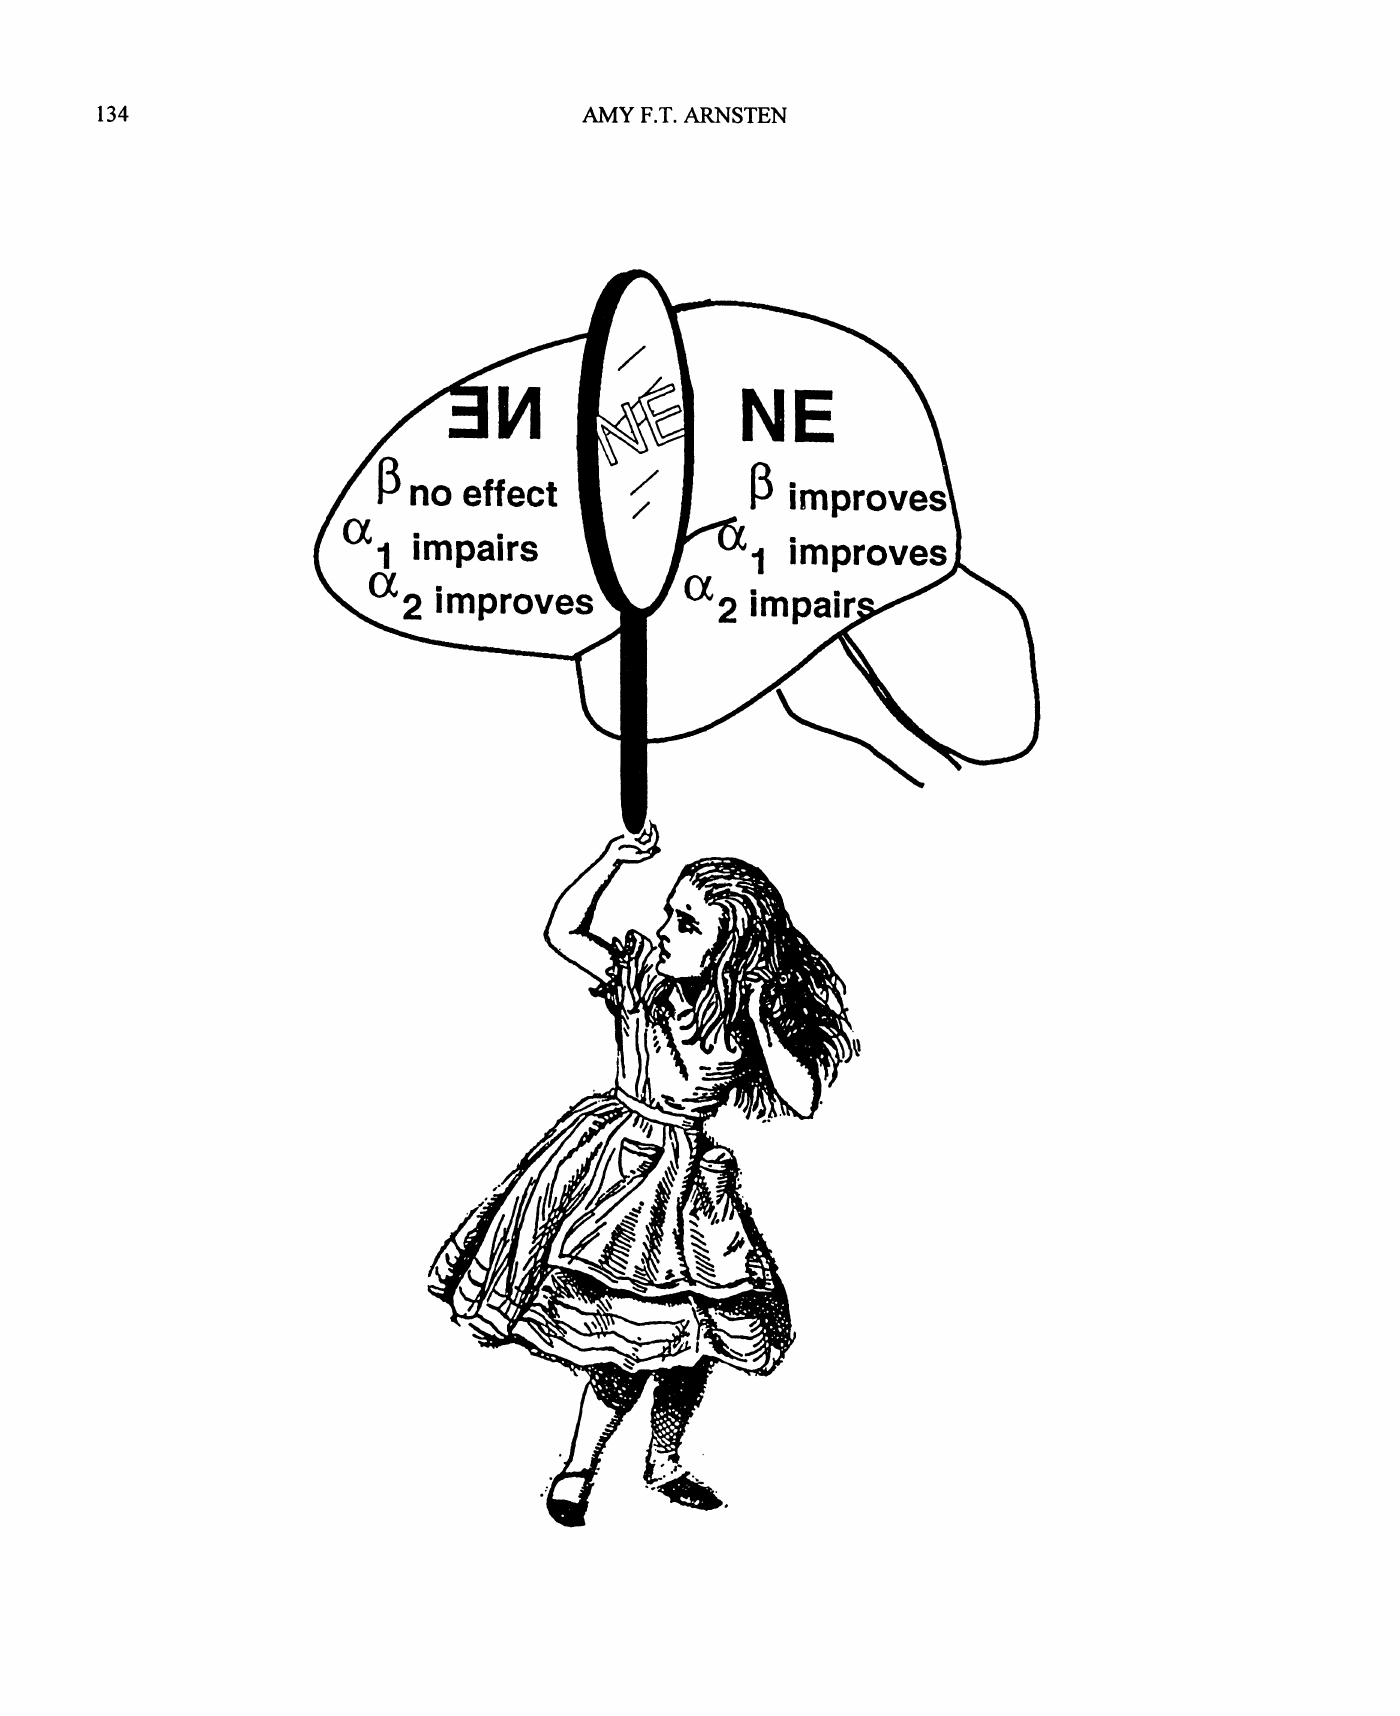
Fig. 1" The neurochemical needs of the PFC appear to be "upside down and backwards" from those of posterior cortical and subcortical structures. See text for